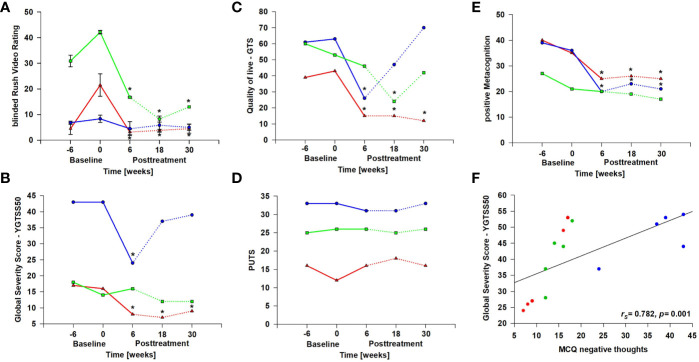
Study results. Absolute values are given for each patient (patient 1 = red, patient 2 = blue, patient 3 = green). Dashed lines indicate post intervention time points. * Reliable Change Indices (RCIs) indicating that individual change scores are statistically significantly greater than expected by chance. (A) Rush Video-Based Rating Scale: in the Rush Video scale the subjective improvement was verified by two blinded raters to whom videos were presented in a random manner. Inter-rater correlation was rS=0.96 (
Figure S1
). (B) YGTSS50: Yale Global Tic Severity Scale. (C) GTS-QoL: Gilles de la Tourette syndrome-quality of life scale. (D) PUTS: Premonitory Urge for Tics Scale. (E) MCQ30 positive metacognitions: Metacognitive Questionnaire, subscale “positive beliefs about worry” (such as “worrying helps me to avoid problems in the future”). (F) shows the correlation between Tic severity as measured with the YGTSS50 and MCQ30 negative metacognitions: Metacognitive Questionnaire, subscale “negative beliefs about worry” (such as “worrying is dangerous for me”).